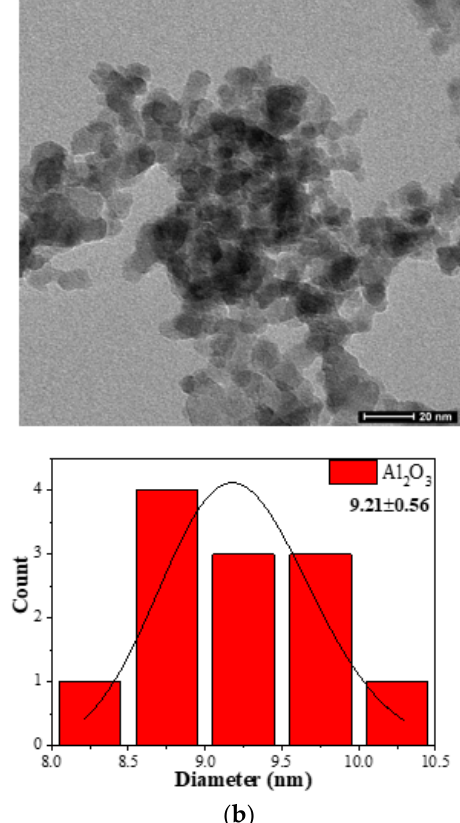
Table 2. The properties of Al 2 O 3 nanoparticles, which were used for nanofluid preparation [48].